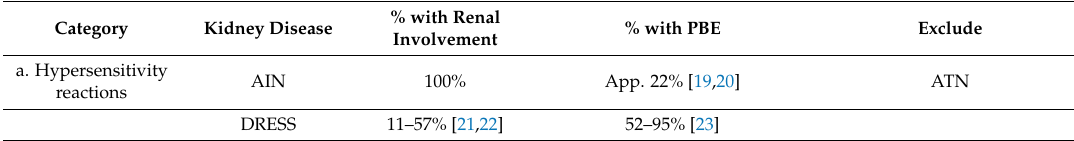
Table 2. Overview of conditions associated with renal disease and eosinophilia. Cautious interpretation is necessary, since glucocorticoid treatment can mask